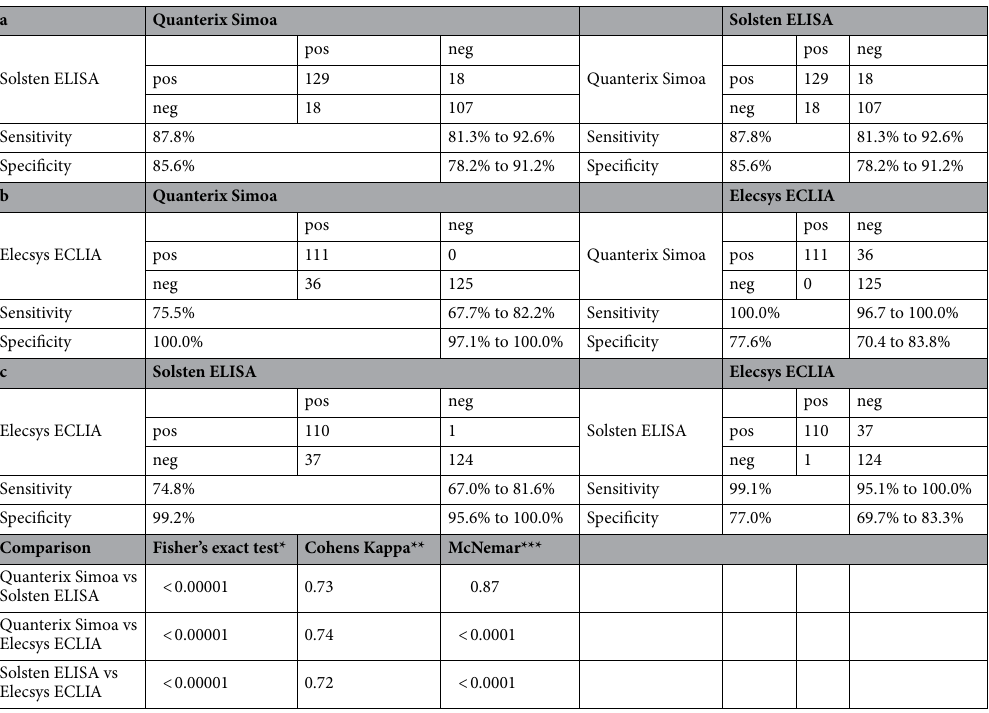
Table 3. 2 × 2 contingency tables between each assays with resulting diagnostic performance with each assay set as truth. *P-value. **Kappa value, substantial agreement.